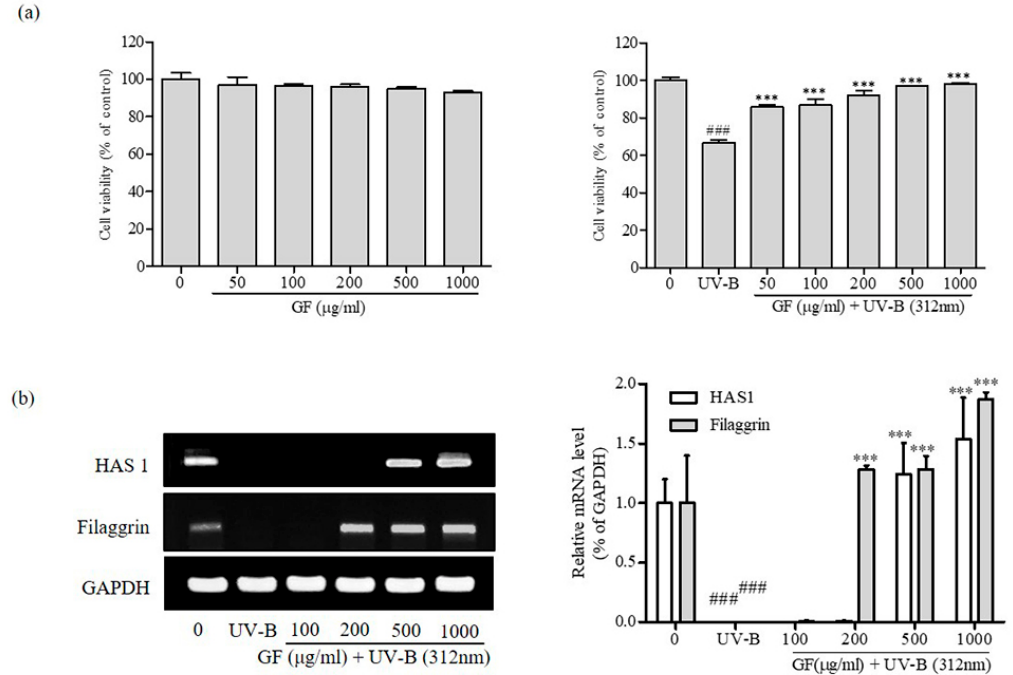
Figure 4. GF activates HAS1 and filaggrin mRNA expression in human fibroblast CCD-986sk cells. ( a ) CCD-986sk cells were treated with various concentrations of GF (50–1000 µ g / ml) for 24 h after vehicle (left panel) or UV-B (312 nm) exposure for 5 min (right panel). After treatment, cell viability was measured using a WST-1 assay. ( b ) The HAS 1 and filaggrin mRNA levels were measured by RT-PCR analysis in CCD-986sk cells. The bar graphs represent the quantitation of RT-PCR data. The absorbance was measured by an ImageJ. GAPDH was used as an internal control. Data are presented as mean ± SEM. ### p < 0.001 compared to nonstimulated cells (GF 0 µ g / ml). *** p < 0.001 compared to UV-B exposed cells.